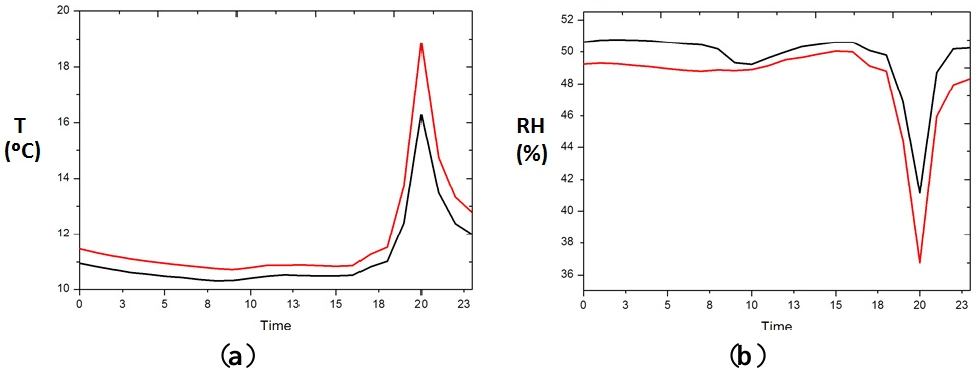
Figure 6. Daily mean trajectories for back (black) and front (red), for days when the heating system is switched on, ( a ) temperature, ( b )